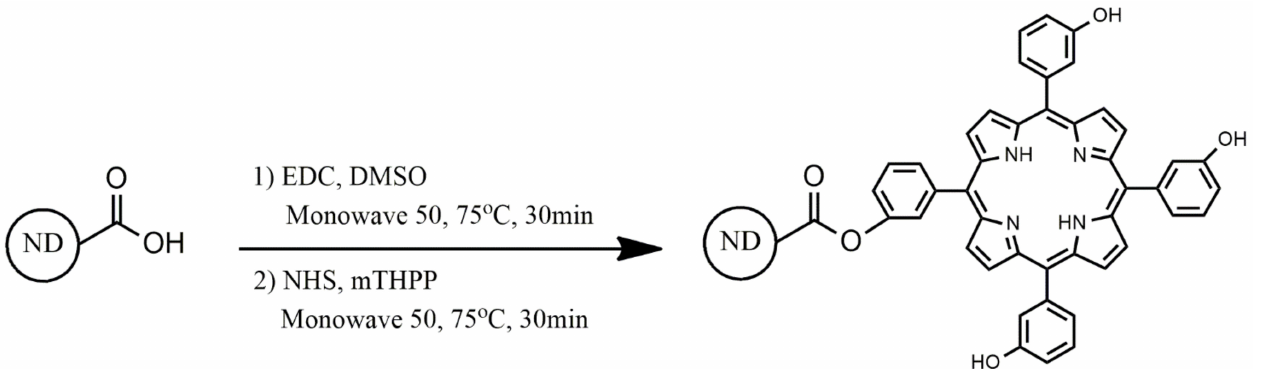
Figure 1. Schematic representation (out of scale) of the conjugation of mTHPP with ND-COOH through esterification resulting in ND-mTHPP nanoconjugate